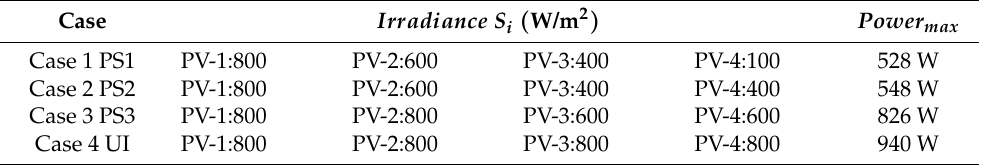
Figure 12. Complete Simulink model of MLPE distributed PV system. Table 3. P-V and I-V characteristic curves at different irradiance values of MLPE Distributed PV